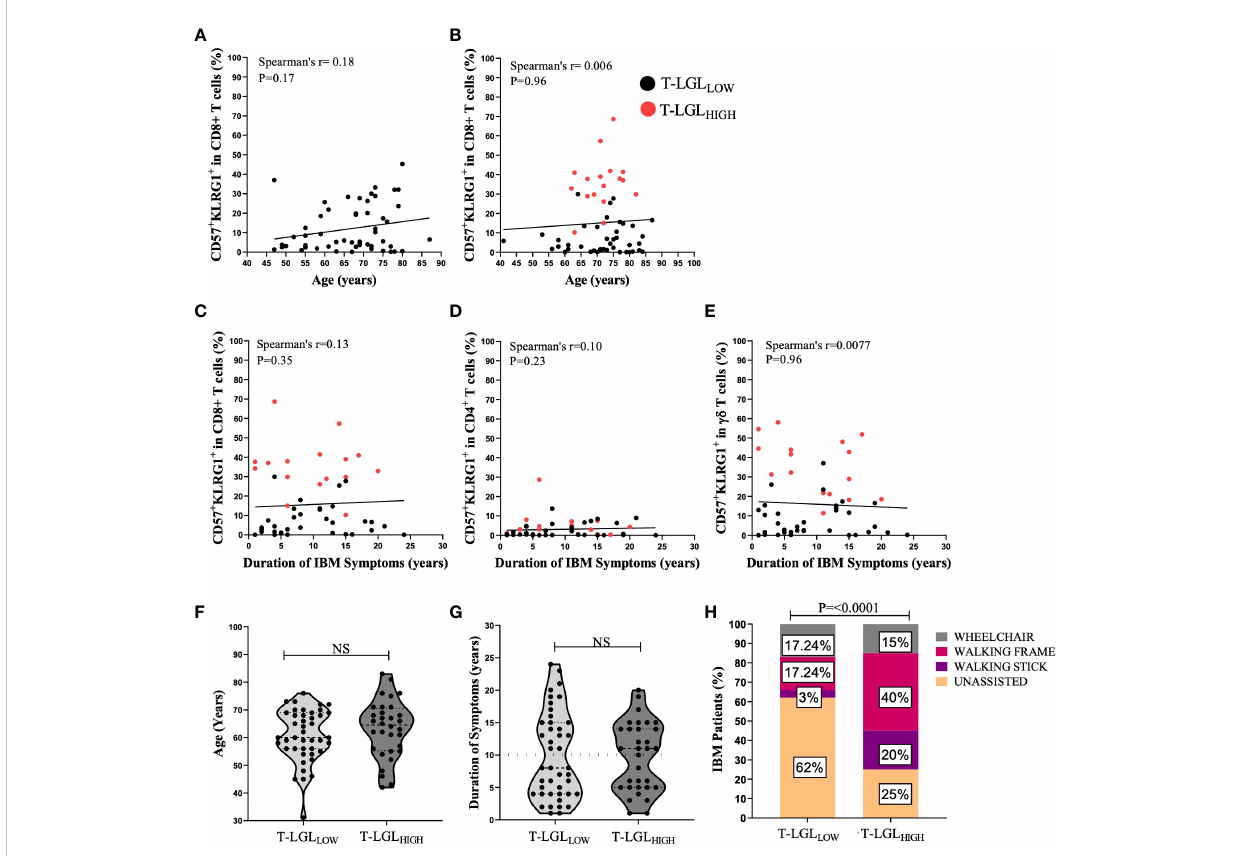
FIGURE 9 Clinical correlations of T-LGL expansions within IBM patients. (A, B) Spearman ’ s correlation between the proportion of CD8 + CD57 + KLRG1 + versus age in H.C (n=54) and IBM (n=59) respectively. (C – E) Spearman ’ s correlation shows the duration of IBM duration of symptoms (years) versus the proportion of CD8 + CD57 + KLRG1 + and CD4 + CD57 + KLRG1 + and gd CD57 + KLRG1 + respectively (n=52). (F) Difference between the age at onset (years) in IBM